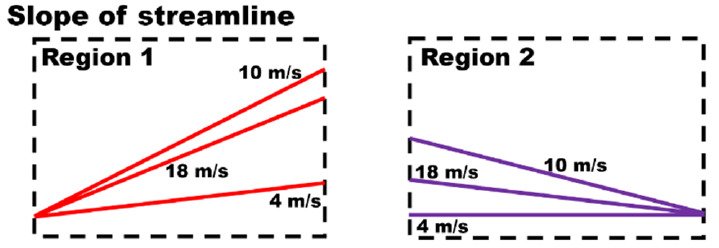
Figure 9. Slope comparation of streamlines in region 1 and region 2 in the three cases (4 m/s, 10 m/s, and 18 m/s).